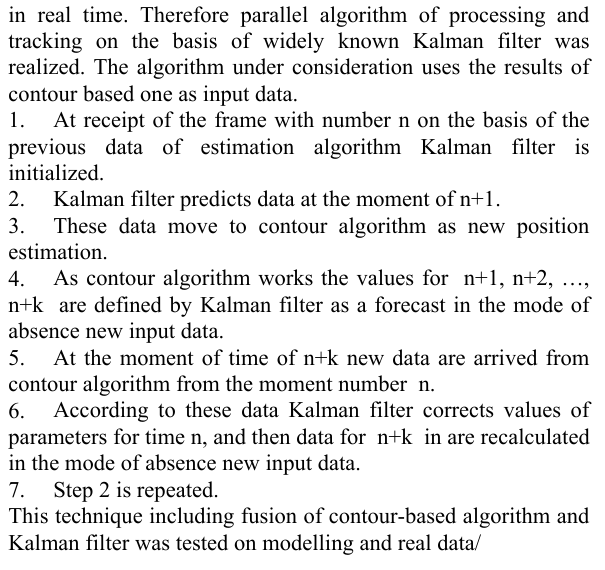
7. Step 2 is repeated. This technique including fusion of contour-based algorithm and Kalman filter was tested on modelling and real